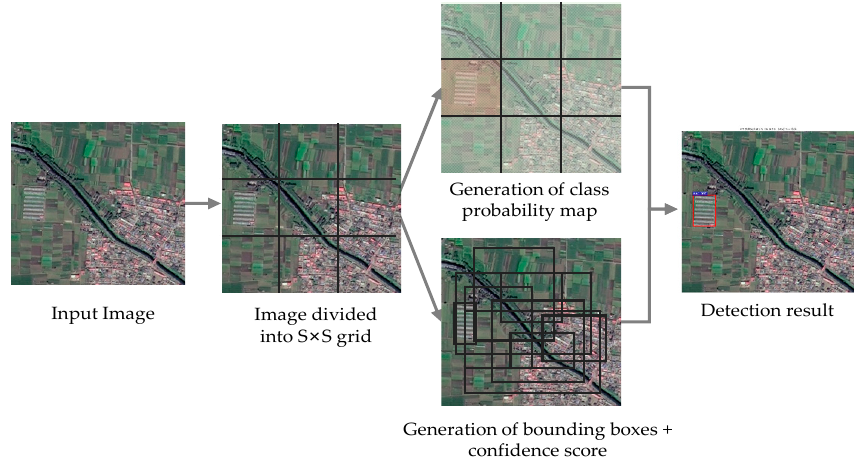
Figure 3. Stages of YOLO v3 model in detecting AGs.